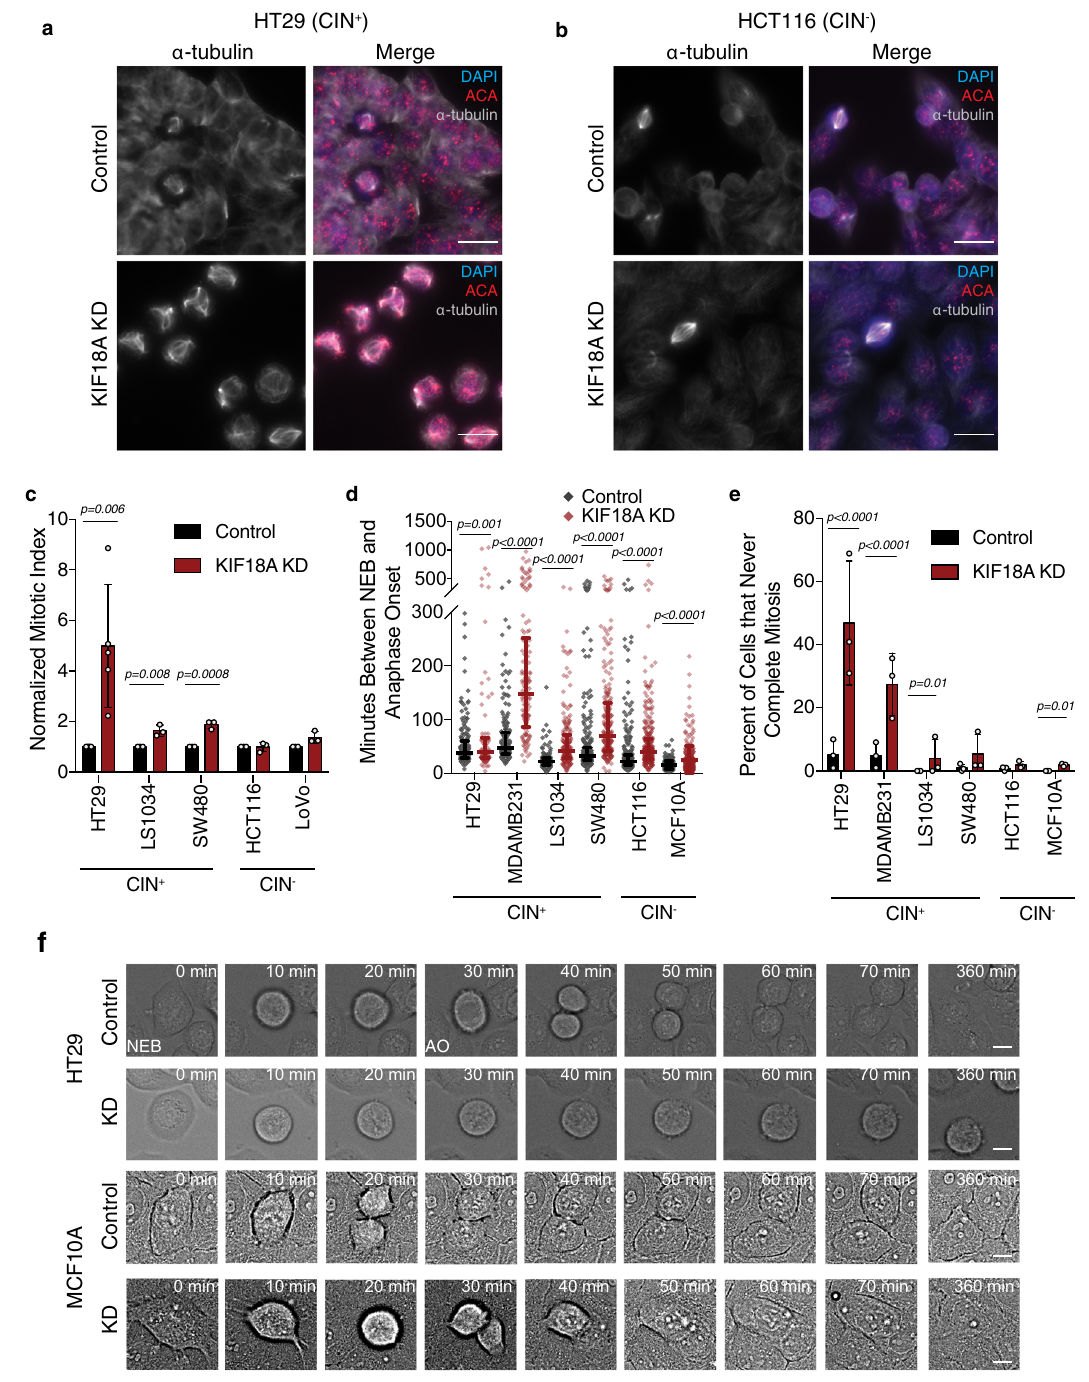
Fig. 3 KIF18A depletion causes mitotic arrest in CIN cancer cells. a , b Representative images from fi ve and three independent experiments of HT29 ( a ) or HCT116 cells, respectively, ( b ) treated with control or KIF18A siRNAs. DNA (DAPI, blue), microtubules ( α -tubulin, white), and centromeres (ACA, red) are labeled. Scale bars are 10 microns. c Percentage of mitotic cells (mitotic index) observed in fi xed populations of control or KIF18A siRNA-treated CRC cells. n = three independent biological samples per condition for LS1034, SW480, HCT116, and LoVo; n = 5 for HT29. Data were analyzed via unpaired, two- tailed t test. d Time between nuclear envelope breakdown (NEB) and anaphase onset (AO) in control or KIF18A siRNA-treated cells. Data from three independent experiments are shown for each cell line. n (control KD/KIF18A KD cells) = 185/ 83 (HT29), 182/135 (MDA-MB-231), 203/196 (LS1034), 303/236 (SW480), 332/344 (HCT116), and 338/353 (MCF10A). Data were analyzed via unpaired, two-tailed t test. e Percentage of control or KIF18A siRNA-treated cells that entered mitosis at least 200 min before the end of the movie but did not divide. Data are from the same three experiments as d and were analyzed by a two-sided Chi-square test. n (control KD/KIF18A KD cells) = 191/153 (HT29), 189/195 (MDA-MB-231), 203/202 (LS1034), 310/ 249 (SW480), 335/351 (HCT116), and 338/367 (MCF10A). f Frames from DIC live-cell imaging of HT29 and MCF10A cells treated with control or KIF18A (KD) siRNAs, showing the progression from NEB to AO. Scale bars are 5 microns, representative of three independent experiments. All graphs show mean ± SD and individual data points. P values <0.05 are